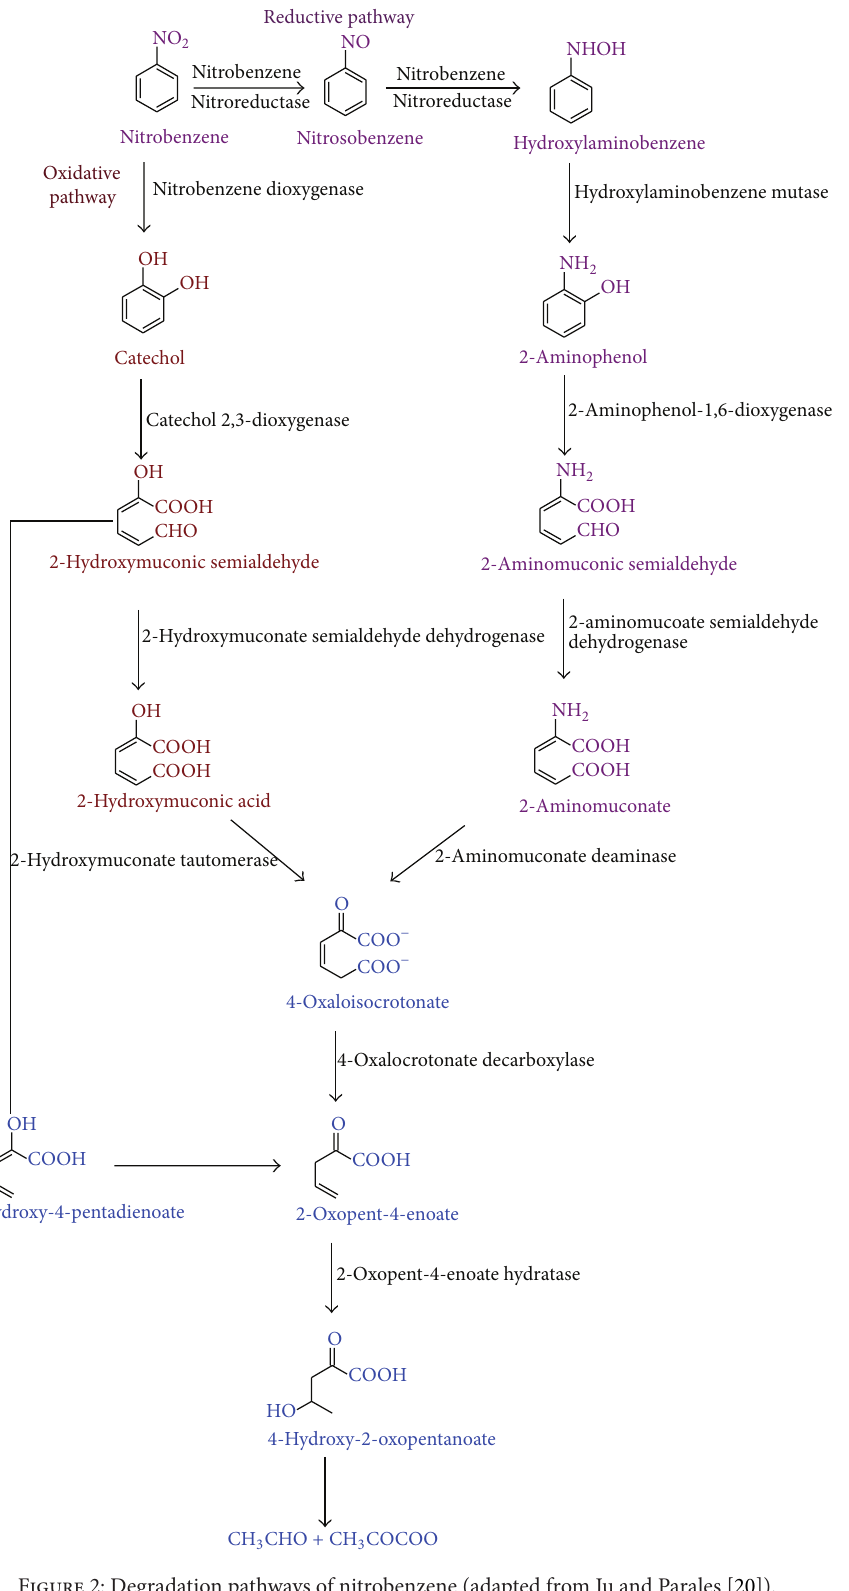
Figure 2: Degradation pathways of nitrobenzene (adapted from Ju and Parales